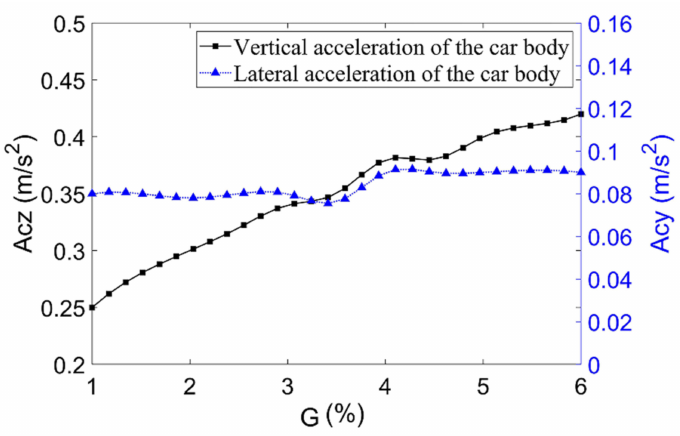
Figure 11. Record of vertical force of guiding wheels.